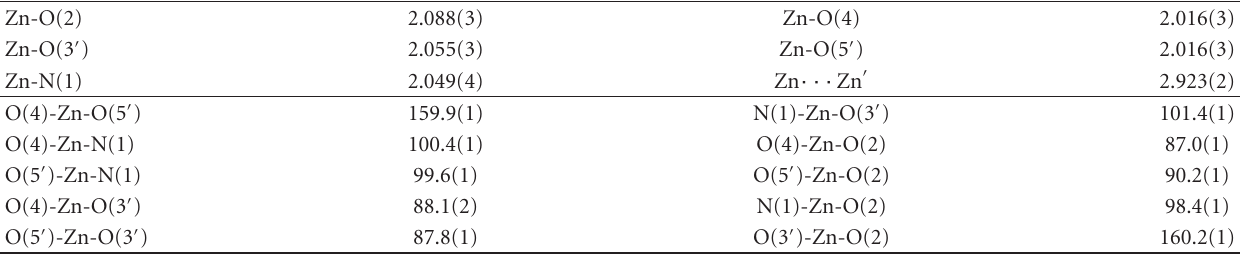
Table 3: Selected interatomic distances ( ˚A) and angles ( ◦ ) for complex 2 a .